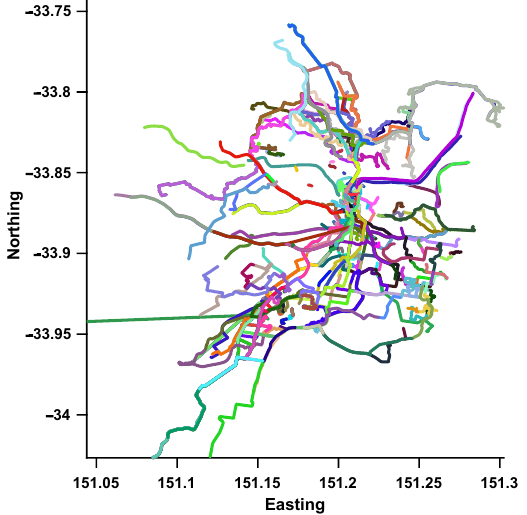
Figure 3. GPS Tracks of the image sequences collected around Sydney from